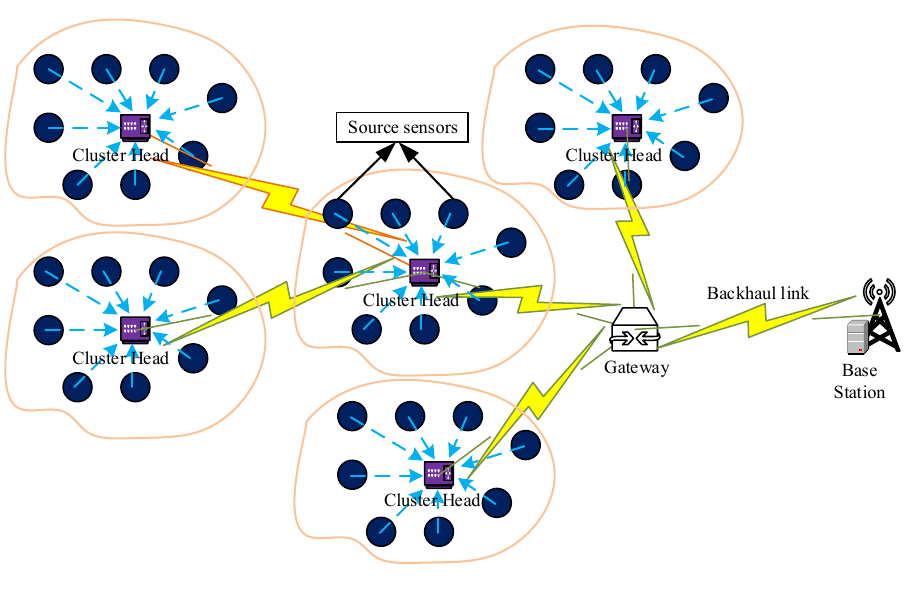
Figure 2. A scenario of a periodic wireless sensor network (WSN) for a long-term monitoring